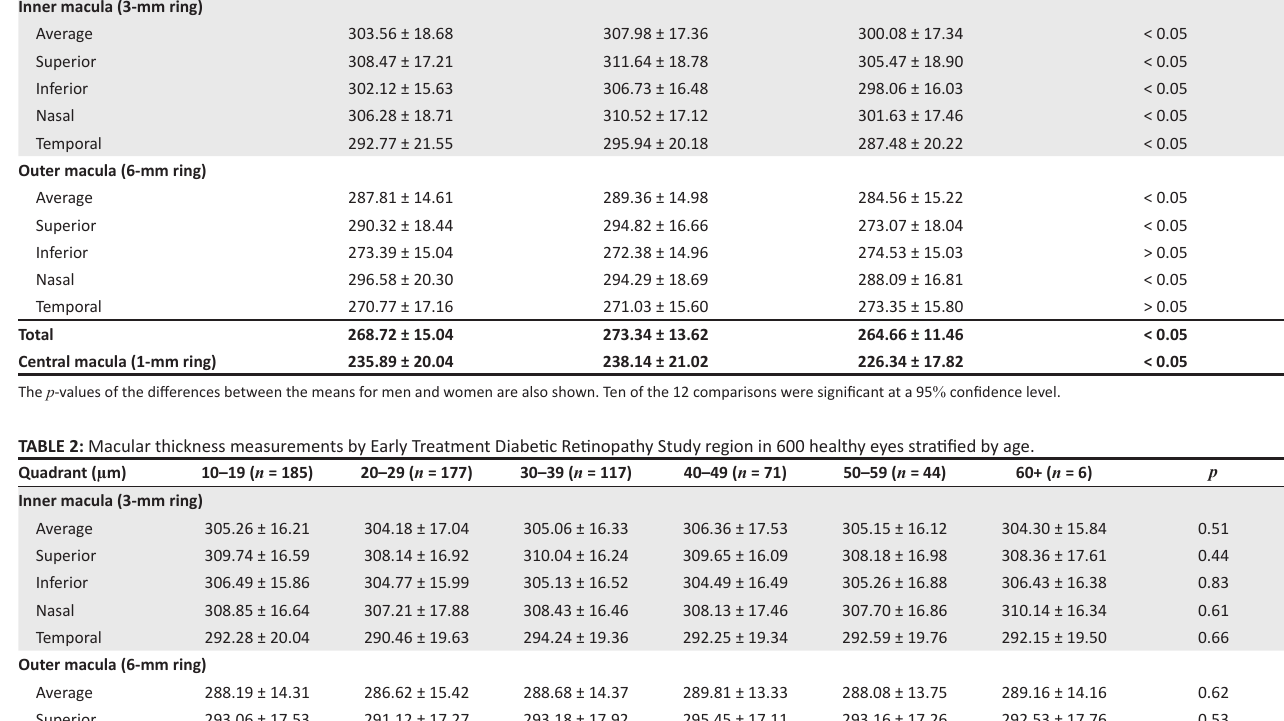
TABLE 1: Macular thickness measurements in each Early Treatment Diabetic Retinopathy Study region by gender in 600 healthy eyes using the iVue-100 spectral-domain optical coherence tomography system. Quadrant ( µ m)